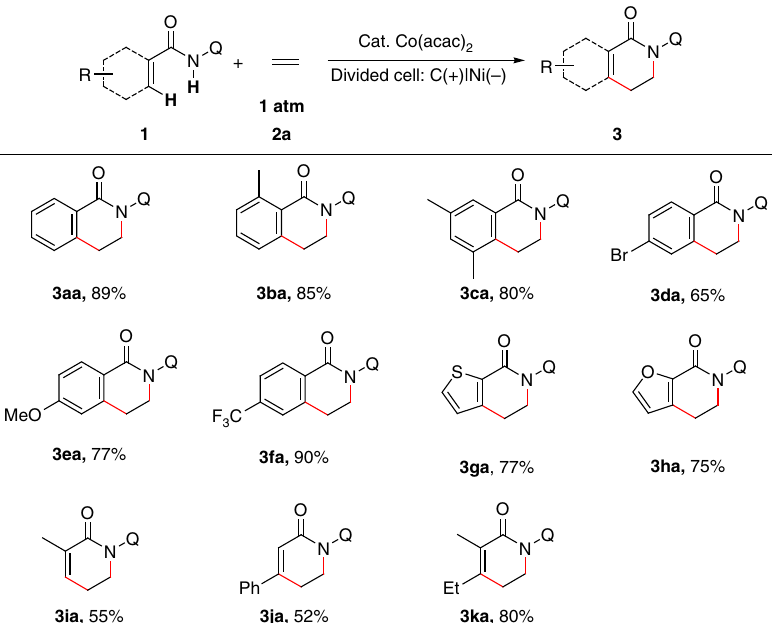
Fig. 2 Electrooxidative C – H/N – H [4 + 2] annulation with ethylene. Reaction conditions: 1 (0.20 mmol), Co(acac) 2 (15 mol%), NaOPiv·H 2 O (1.5 equiv), n with carbon cloth anode, nickel plate cathode, and an AMI-7001-30 membrane, constant current = 4.0 mA ( J anode = 1.8 mA/cm 2 ), ethylene balloon (1 atm), 70 °C, 4 h (3.0 F/mol). Isolated yields are